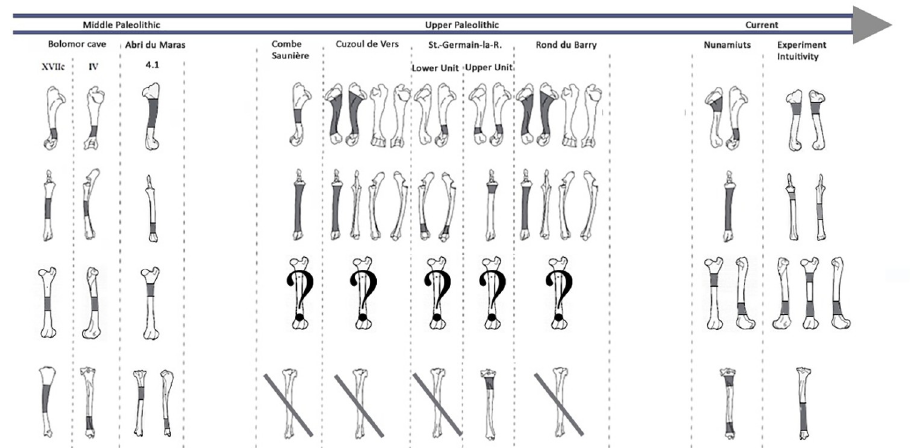
Fig 13. Location of percussion marks (grey areas) for the humerus, radio-ulna, femur, and tibia for sites from the Middle Paleolithic. Sites: Bolomor cave (ungulates: Blasco et al., 2013.) and Abri du Maras (middle sized-ungulates: [61]); the Upper Paleolithic: Combe Sauni è re (reindeer, Solutrean: Castel, 1999), Cuzoul de Vers (reindeer, Badegoulian: [73]), Saint-Germain-la-Rivi è re, Lower Unit (saiga antelope, Lower Magdalenian: [74]) and Upper Unit (saiga antelope: [19]), Rond du Barry (ibex, Upper Magdalenian: [74]), for these series the data regarding the femurs were missing and most of the tibias did not present higher tendencies; Current: Nunamiut people of Alaska (reindeer: [9] and the results of our experiment regarding the CNA). Adapted to